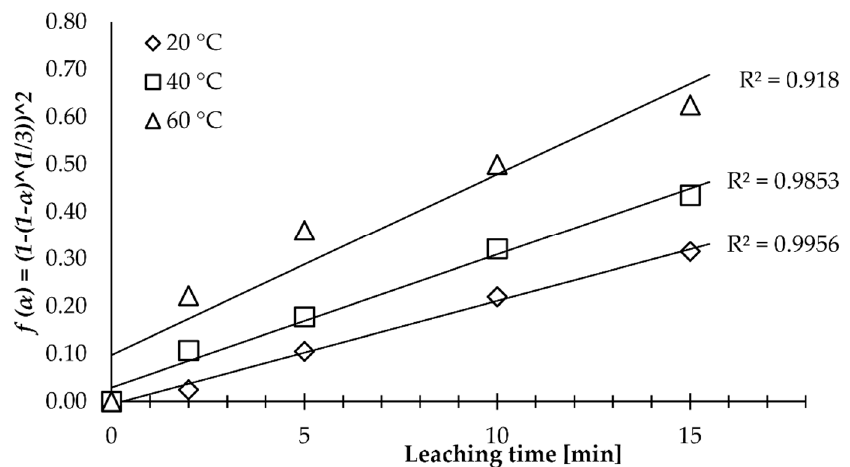
Figure 11. Kinetic data after linearization by cylindrical diffusion kinetic model.